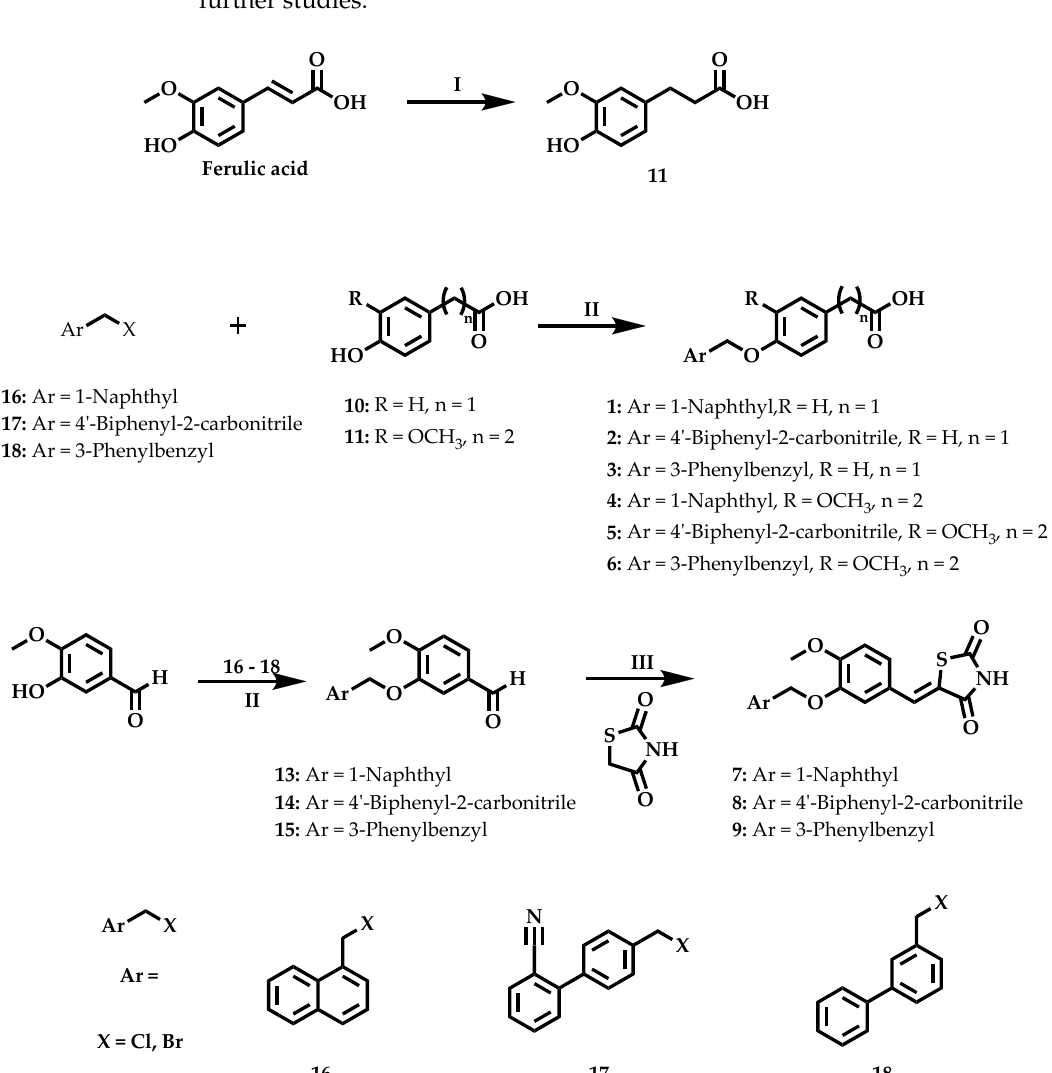
Figure 2. Synthetic route to achieve the desired compounds: ( I ) H 2 , Pd 0 /C, EtOH, R.T.; ( II ) K 2 CO 3 , CH 3 CN, reflux; ( III ) Benzoic acid (0.3 eq.), piperidine (0.3 eq.), toluene, Dean–Stark apparatus, reflux.